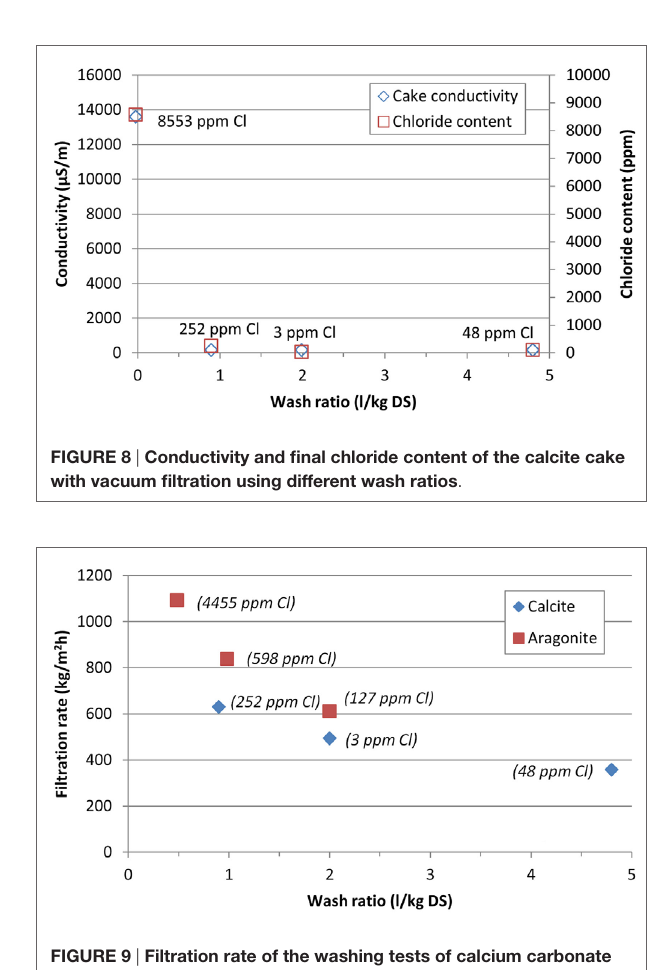
FigUre 9 | Filtration rate of the washing tests of calcium carbonate cakes with vacuum filtration . The final chloride content of the cakes added as text next to the corresponding samples.